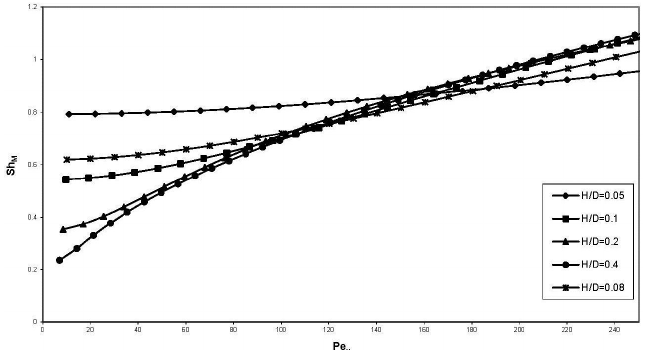
Figure 5. Dependence of the Sh M (Pe y ) function on the thickness of the diffusive layer. B/D = 1; x A1 = x A2 ; limit current; H/D ranges from 0.05 to 0.4.